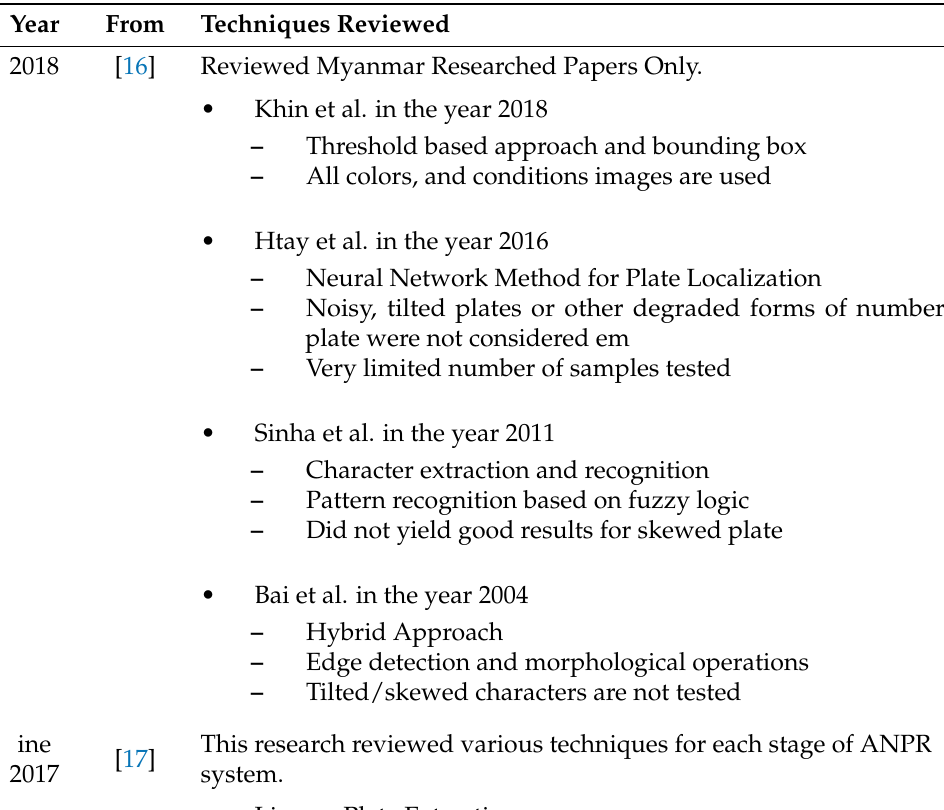
Table 1. Previous Reviews from